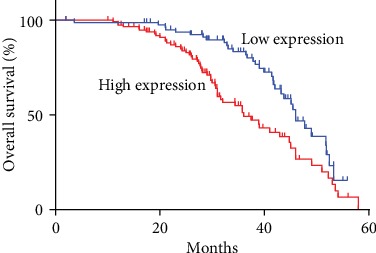
Survival analysis of Cavin3 in lung cancer.